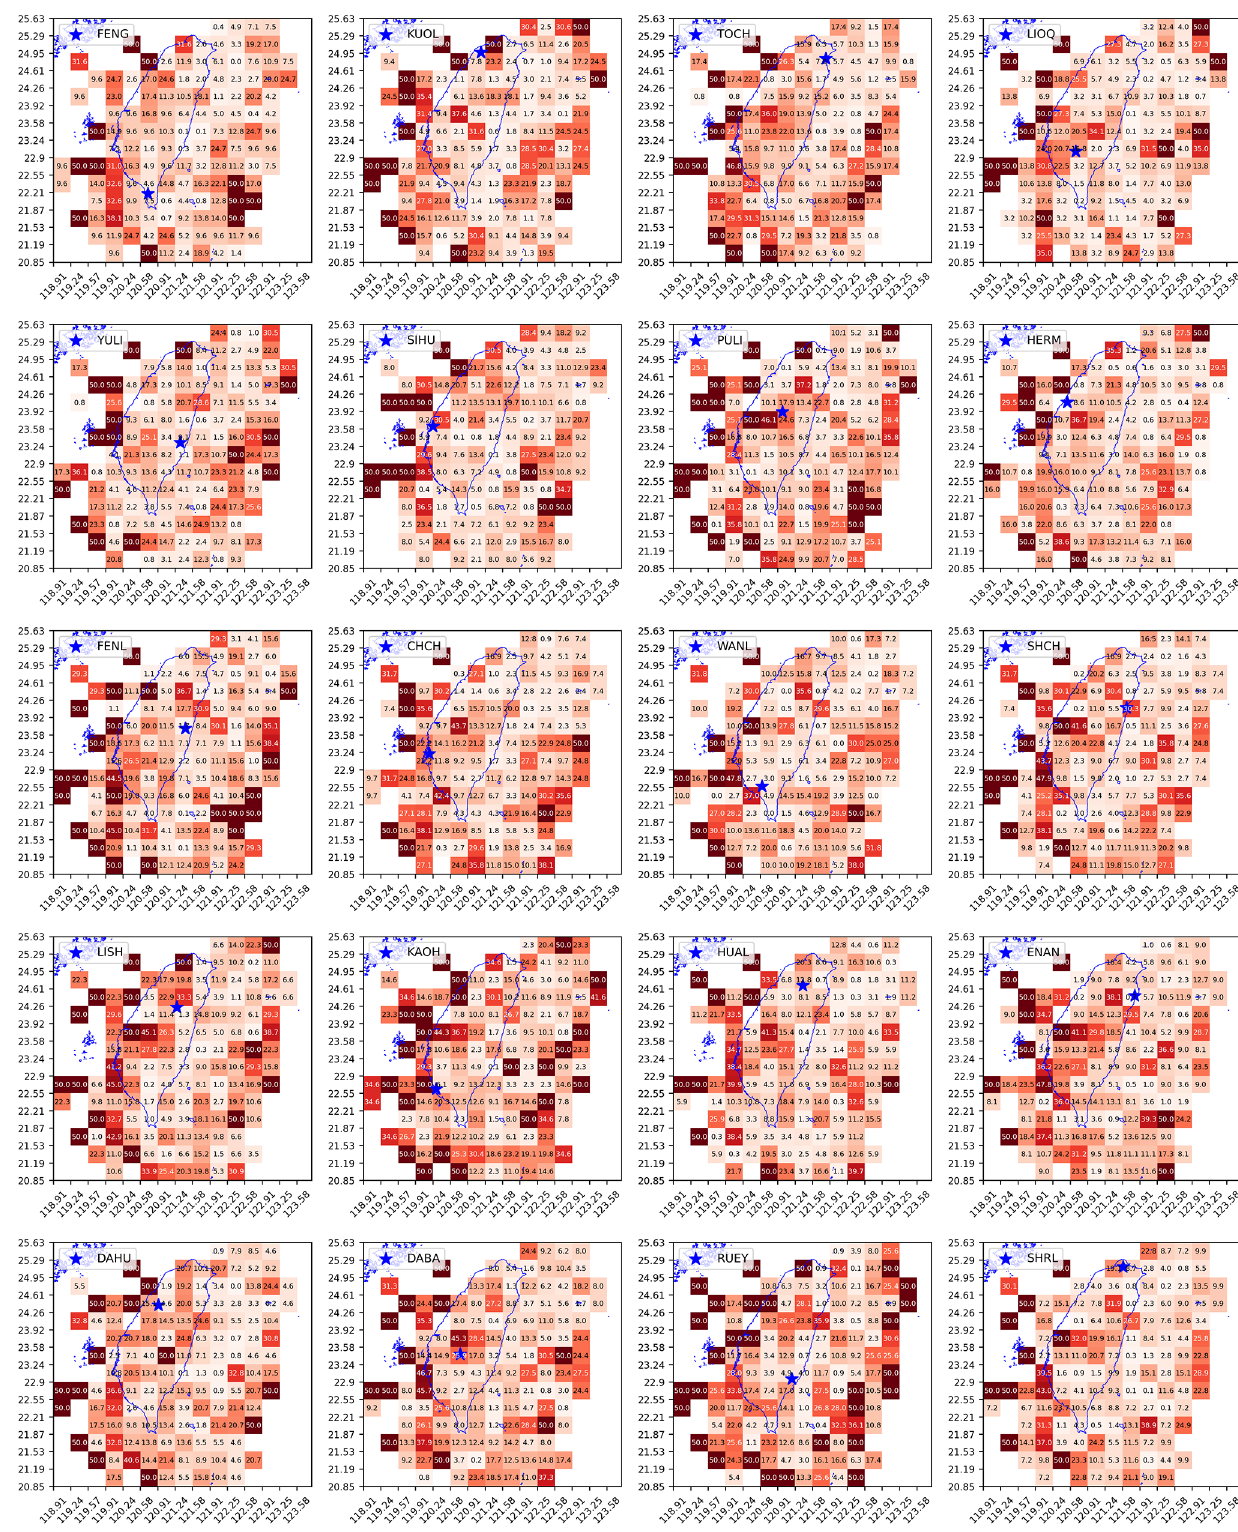
Figure 9. The grid map of discrimination power D( × 0 . 01 ) for 20 stations (obtained using optimal hyperparameters individually specified for each station in Fig.